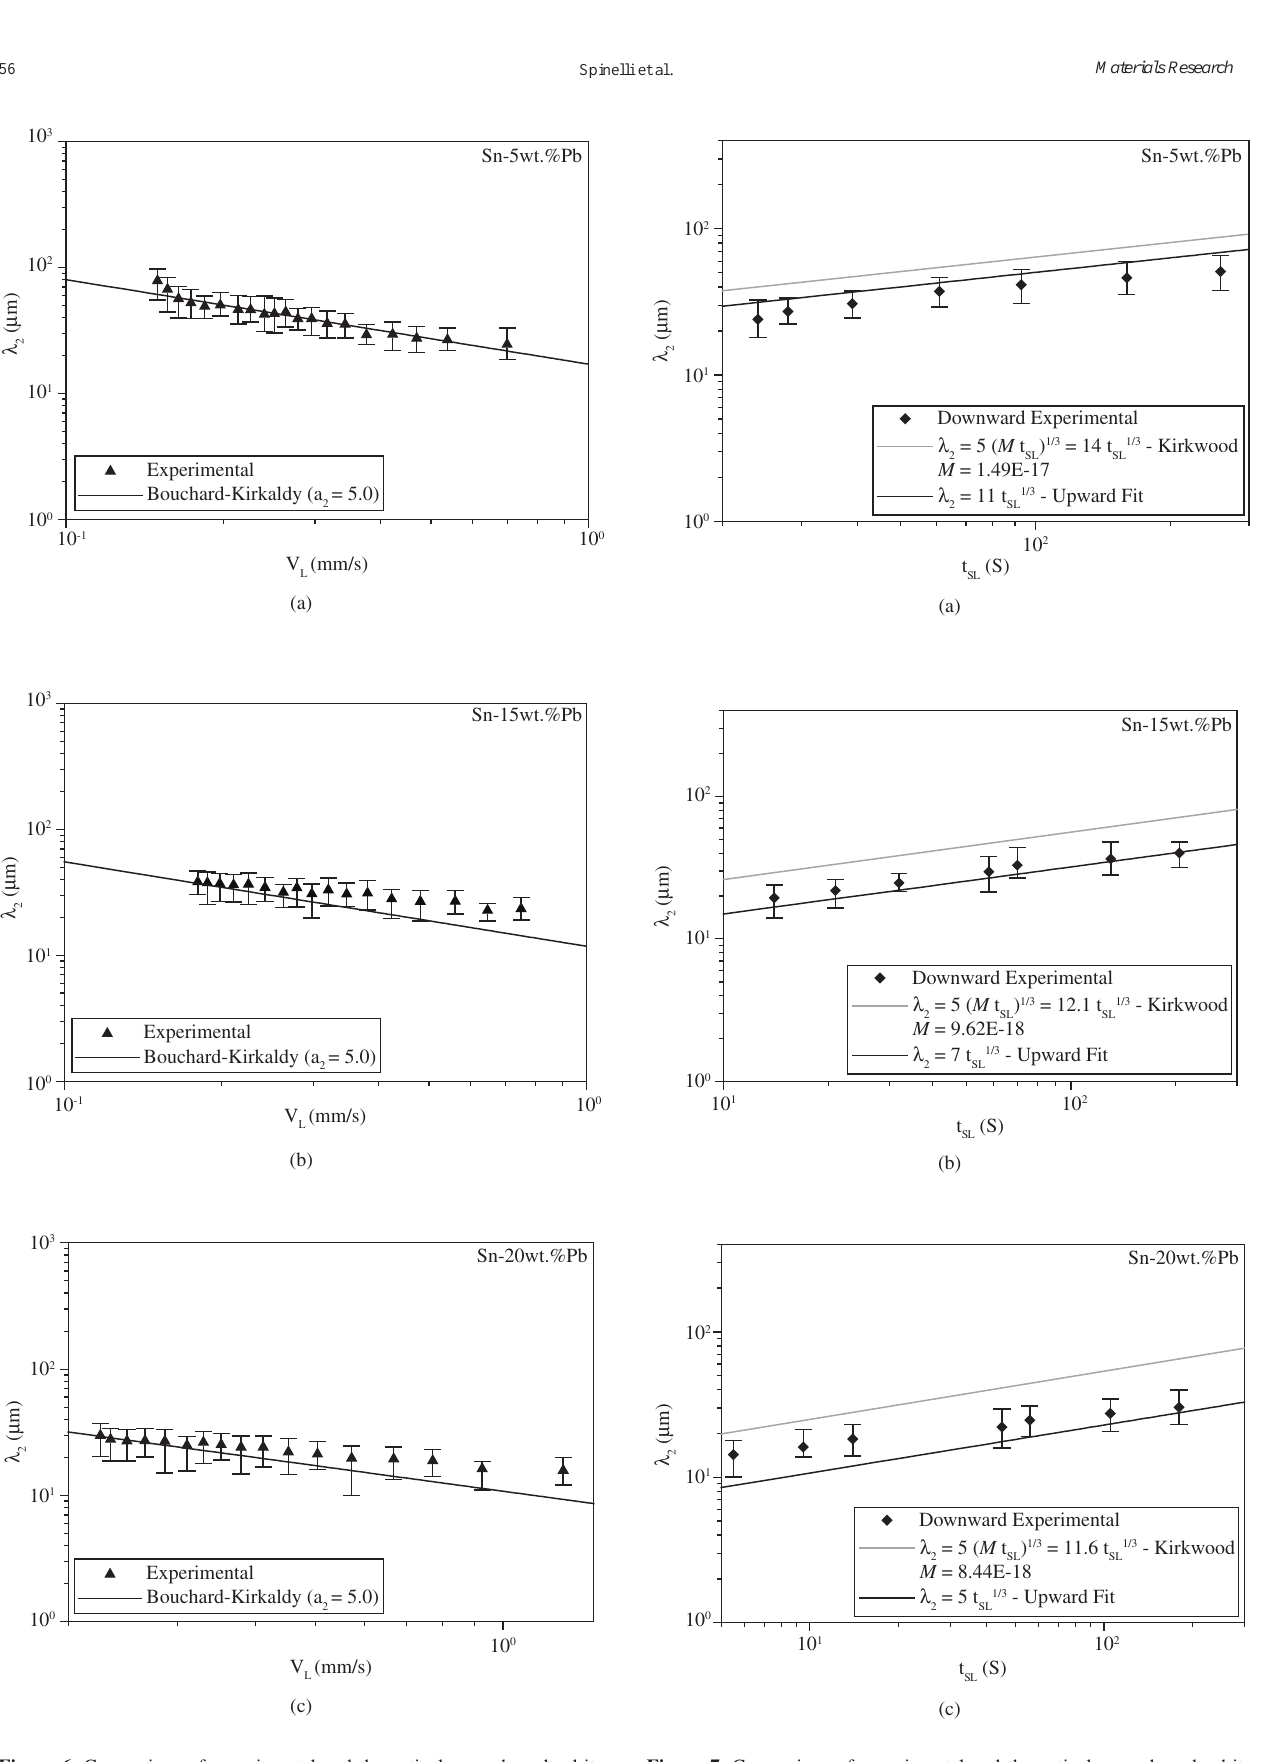
Figure 6. Comparison of experimental and theoretical secondary dendrite arm spacings as a function of tip growth rate for Sn-Pb alloys solidified